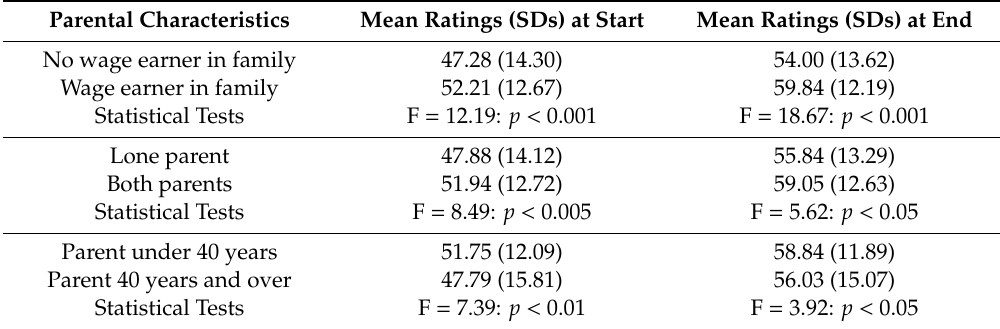
Table 3. The mean and standard deviations (SD) of the wellbeing scores for the subgroupings of parental characteristics at the start and end of the home visits. ( n = 406).